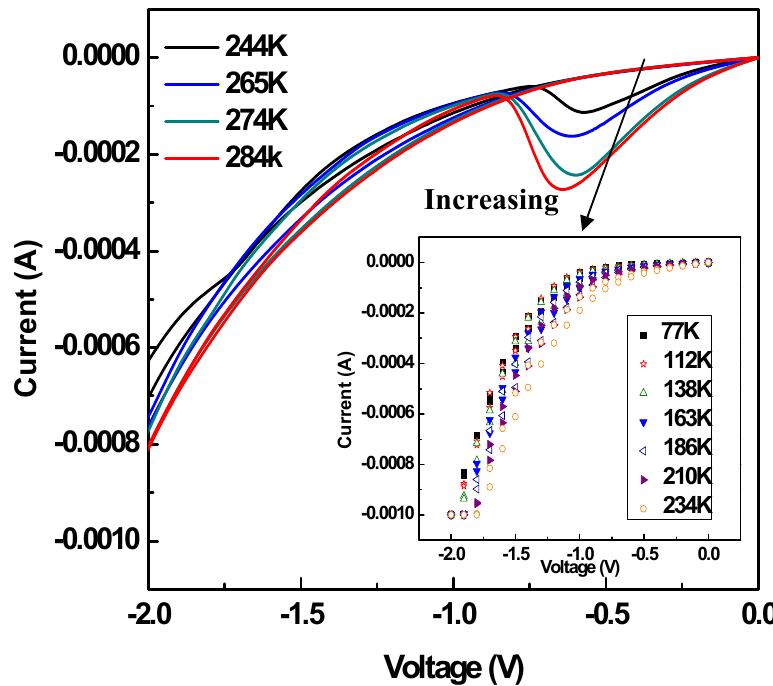
Figure 6. Temperature dependence of monolayer rotor devices with the bisP stator from 77 K to room temperature. In the range of the temperature higher than 244 K, the measured current in the NDR region increases along with temperature. In the range of temperature lower than 244 K, the NDR disappears and the measured currents do not show a significant dependence on temperature as shown in the